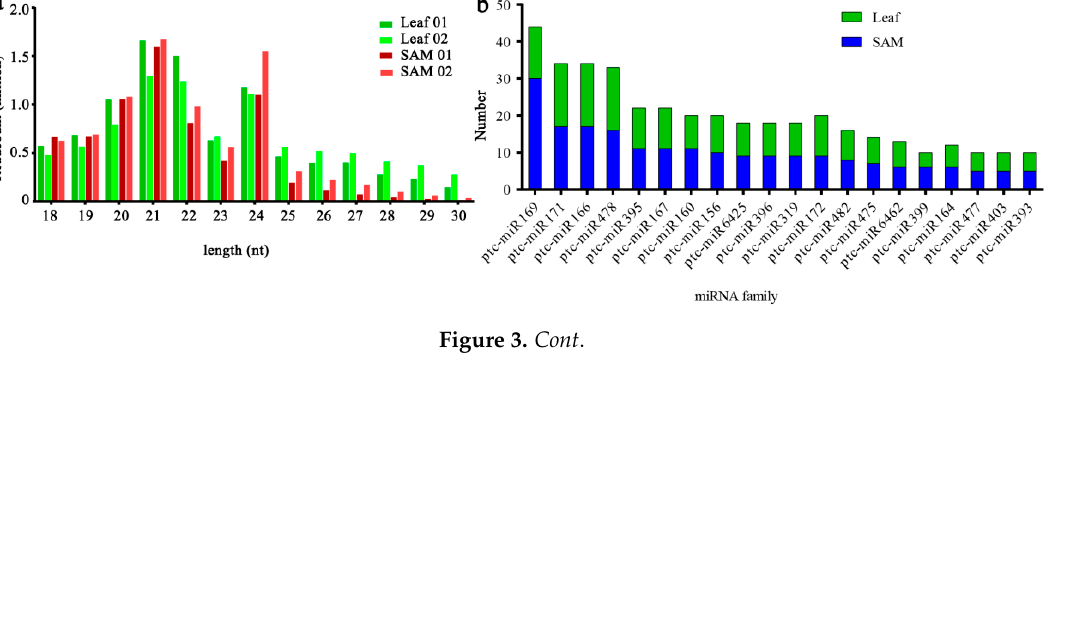
Figure 3. ( a ) Length distributions of the small RNA (sRNA) sequences. ( b ) Number of members within the top 20 known miRNA families. ( c ) Read counts corresponding to the top 20 known microRNA (miRNA) families. 3.3. Identification of Known and Novel miRNAs in P. tomentosa After a sequence similarity search, we identified 349 known miRNAs corresponding to 99 miRNA families. In the SAM, the 328 known miRNAs were grouped into 88 miRNA families. Most of the known miRNA families have several members, and the top five families (miR169, miR171, miR166, miR478, and miR395) possessed 30, 17, 17, 16, and 11 members, respectively, as shown in Figure 3b. In the leaves, the 314 known miRNA sequences were grouped into 89 miRNA families. The numbers of miR478, miR166, miR171, miR169, and miR395 family members in the leaves were 17, 17, 17, 14, and 11, respectively. We also analysed the counts of reads in the known miRNA families, and they indicated large divergences in expression frequency among these miRNA families. The number of reads for conserved miRNAs sequenced from the same or different miRNA families also varied drastically, with miR166, miR159, and miR319 representing the top three families in the SAM and miR166, miR396 and miR159 in the leaf libraries, as shown in Figure 3c. miR166 family members were the most abundant, with 1,422,348.5 and 1,092,946 total reads in the SAM and leaf libraries, respectively. In addition, several miRNAs such as miR1449, miR397, and miR6454 were absent from one of the two libraries (Table S3). This indicated that the miRNA population present in the SAM library differed from that in the leaf library. The remaining unannotated sRNAs were queried against the reference genome, and the mapped reads were used to identify potential novel miRNAs. A total of 1609 mature miRNA sequences were recognised as potential novel miRNAs (Table S4). The high number of potential novel miRNAs might be contributed by their isomirs (for many miRNAs, the same miRNA has several length and/or sequence variants) [38]. The lengths of these mature miRNAs ranged from 19 to 26 nt, with the most common being 24 nt. The minimal free energy range of these novel miRNA precursors was − 66.5 to − 18 kcal/mol, with an average of − 26.23 kcal/mol. 3.4. Analysis of Differentially Expressed miRNAs (DEMs) and their Targets We quantitated the miRNAs in each sample and identified those that were significantly differentially expressed between the SAM and leaves (|log 2 fold-change| > 1, FDR < 0.05). The results